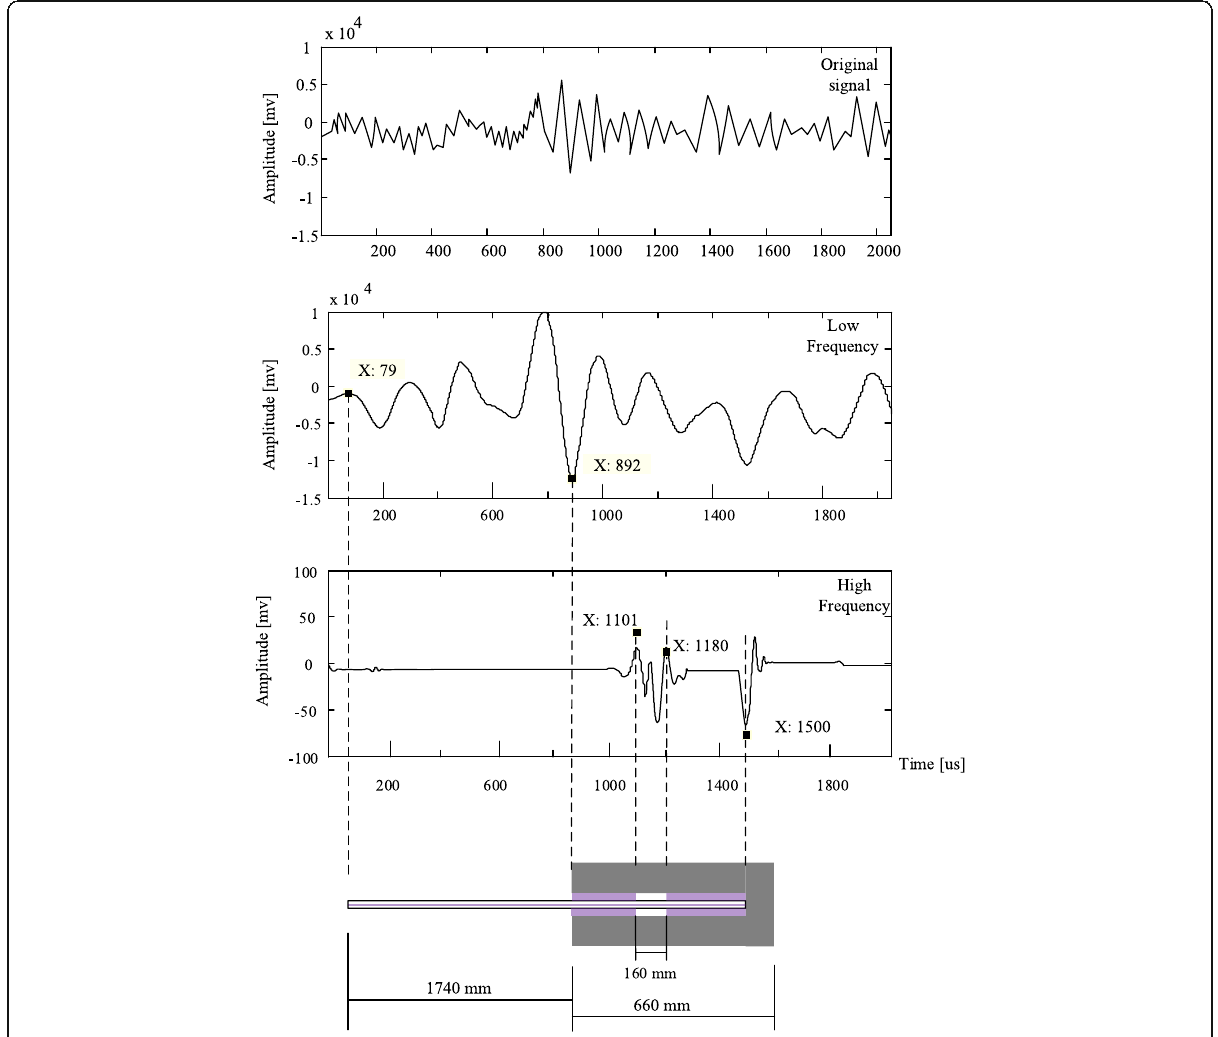
Fig. 9 High-frequency waveform of sample 5# (unit: